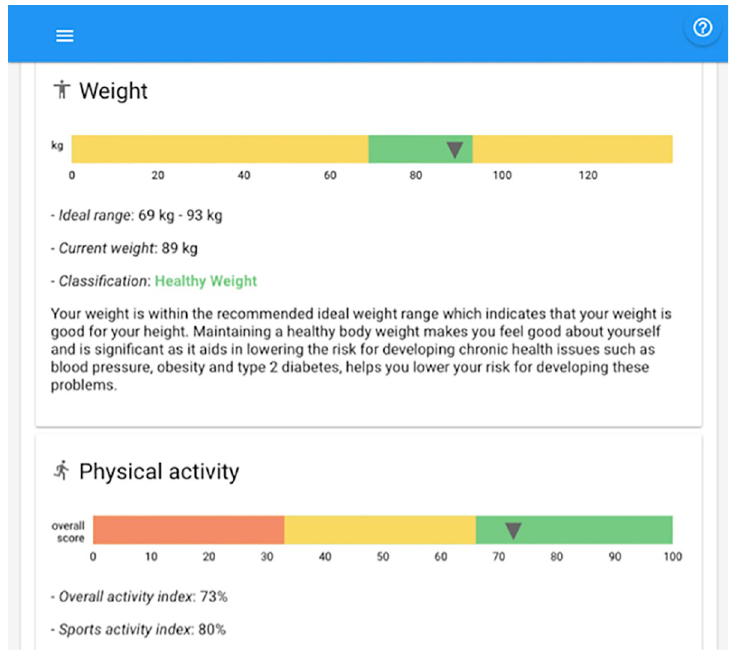
Fig 2. eNutri presenting the weight and physical activity ranges. Reprinted from [10] under a CC BY license, with permission from Rodrigo Zenun Franco, 2019.